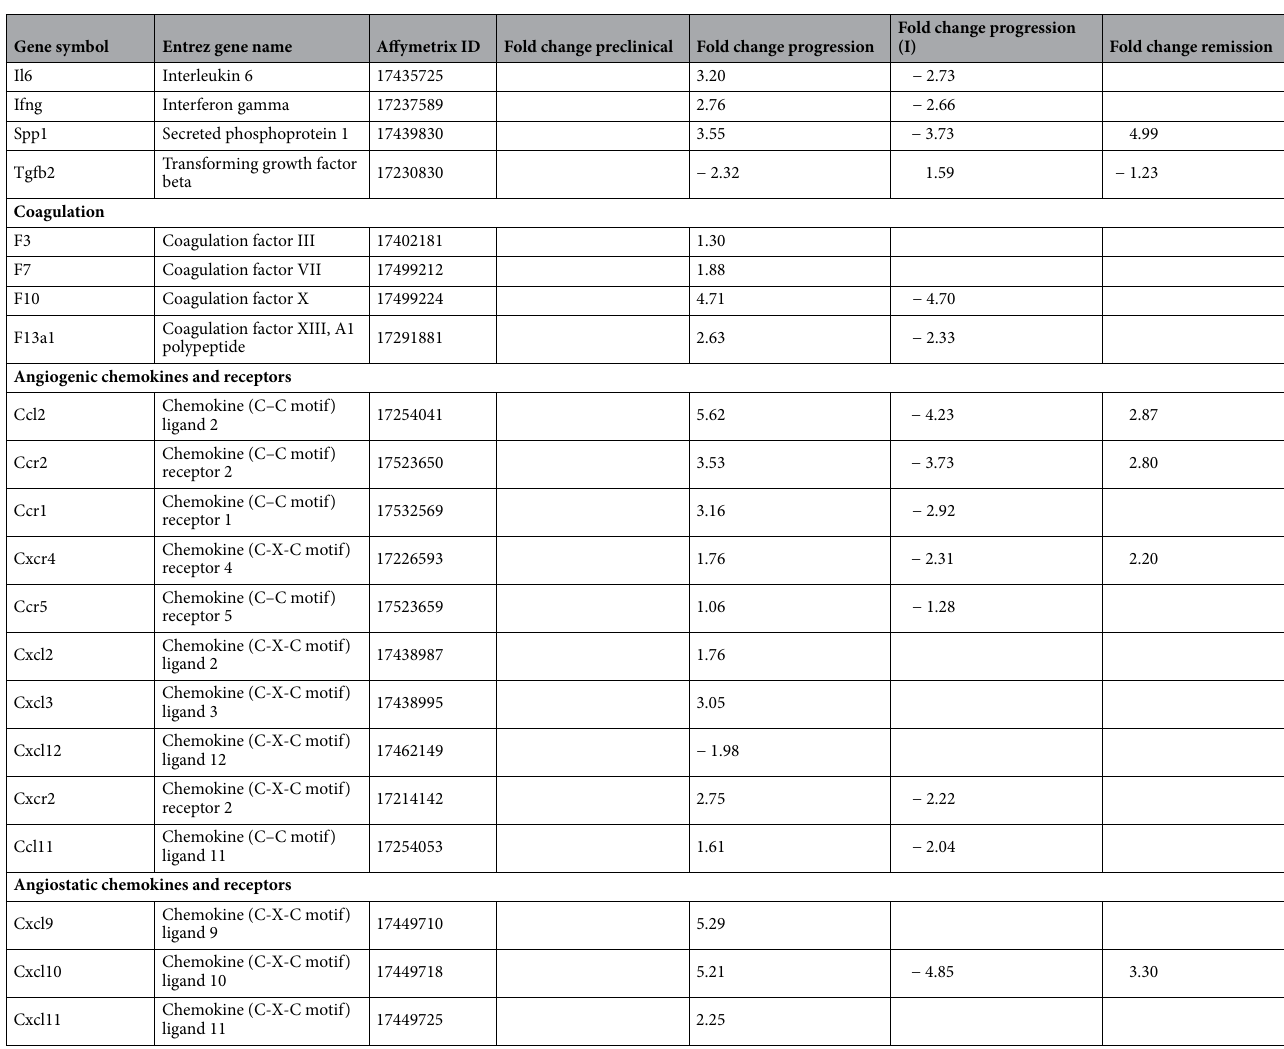
Table 2. Differentially expressed vascular mediators in the BBB transcriptome during the preclinical, progression and remission phase of EAE. Differentially expressed genes between naïve mice and MOG-EAE induced mice during preclinical, progression and remission phase as well as from imatinib compared to PBS treated mice during the progression phase, respectively. An adjusted P value lower than 0.05 and a log2 fold change >1 was used as statistical cut off except for the transcripts indicated with # (adjusted P value 0.07) and * (log twofold change 0.81). Fold change progression (I) refers to the comparison of imatinib versus PBS treated mice during the progression